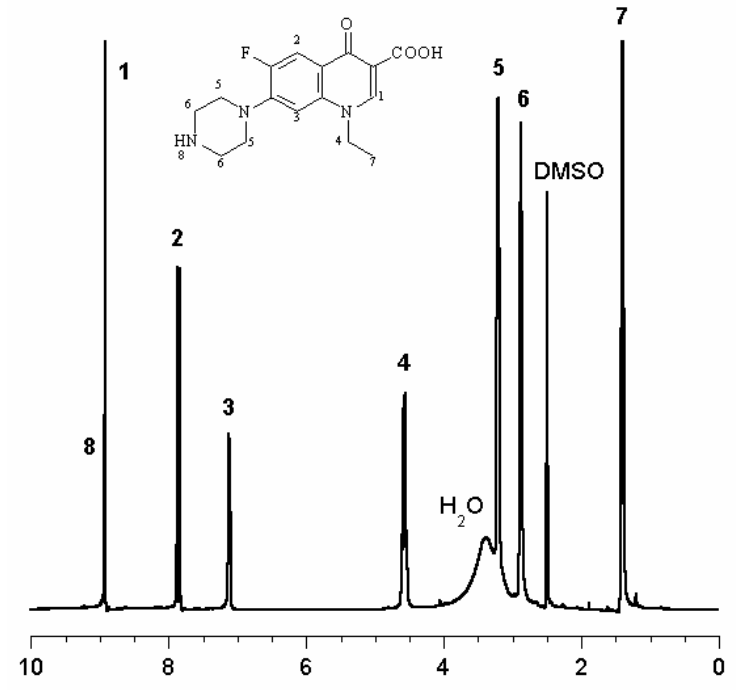
Figure 3 . 1 H-NMR spectrum of NOR (in